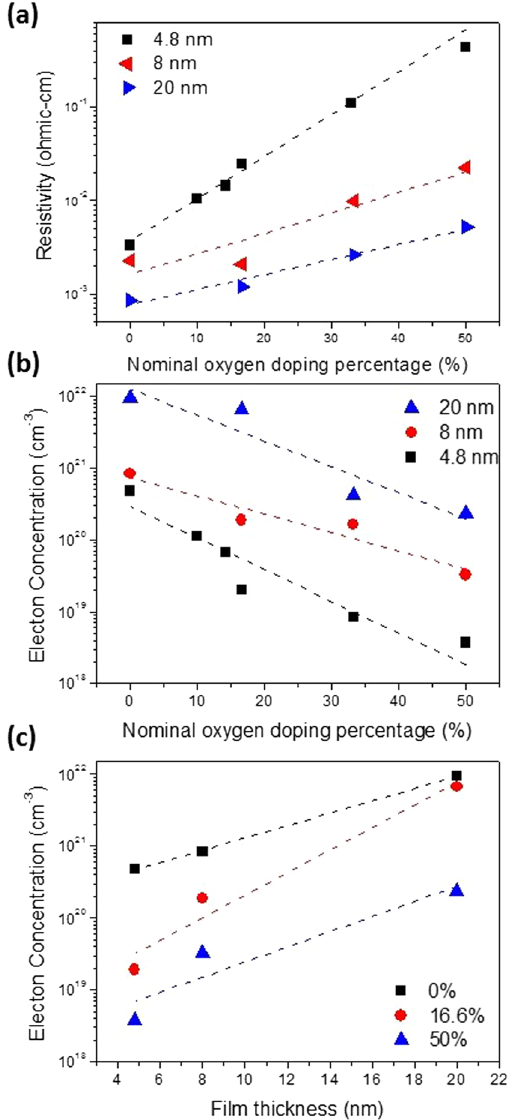
Figure 2. Electrical characteristics of the oxygen-doped TiN layers. ( a ) The resistivity as a function of the nominal oxygen doping percentage ( DP O ) of the layers with different thicknesses. ( b ) The electron concentration as a function of the DP O in the layers with different thicknesses. ( c ) The electron concentration as a function of the film thickness in the layers with different DP O